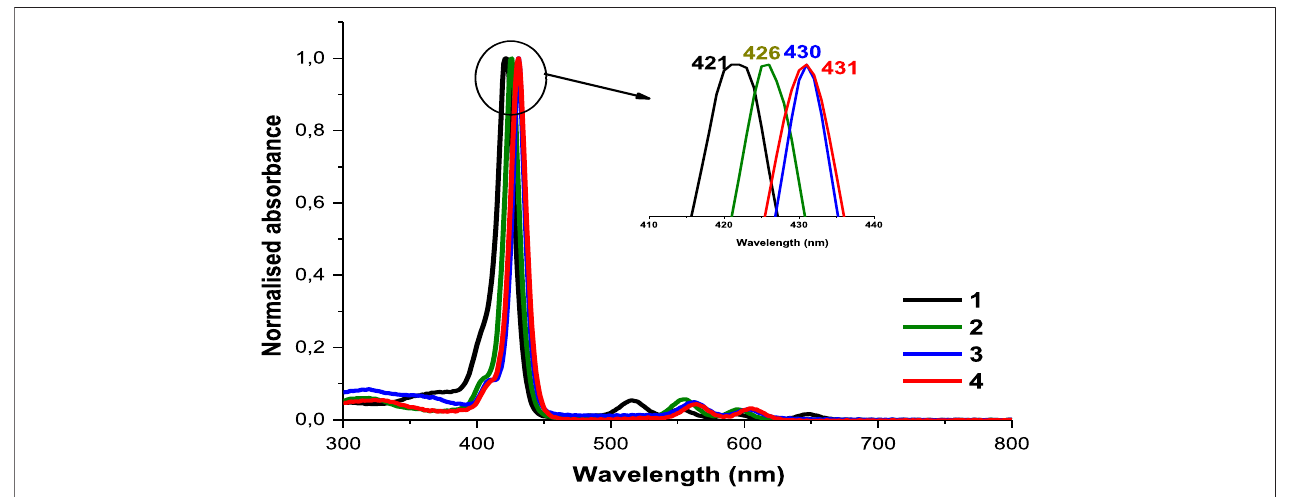
FIGURE 1 | The normalized absorption spectra of asymmetrical porphyrins 1 , 2 , 3 and 4 in DMSO. Arrow shows expansion of the B bands.